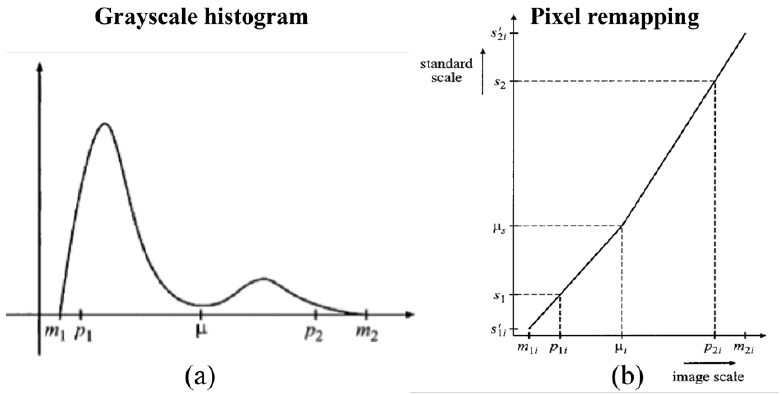
Figure A1. Intensity standardization employed in this study. ( a ) Prostate histogram, ( b ) standardization mapping.